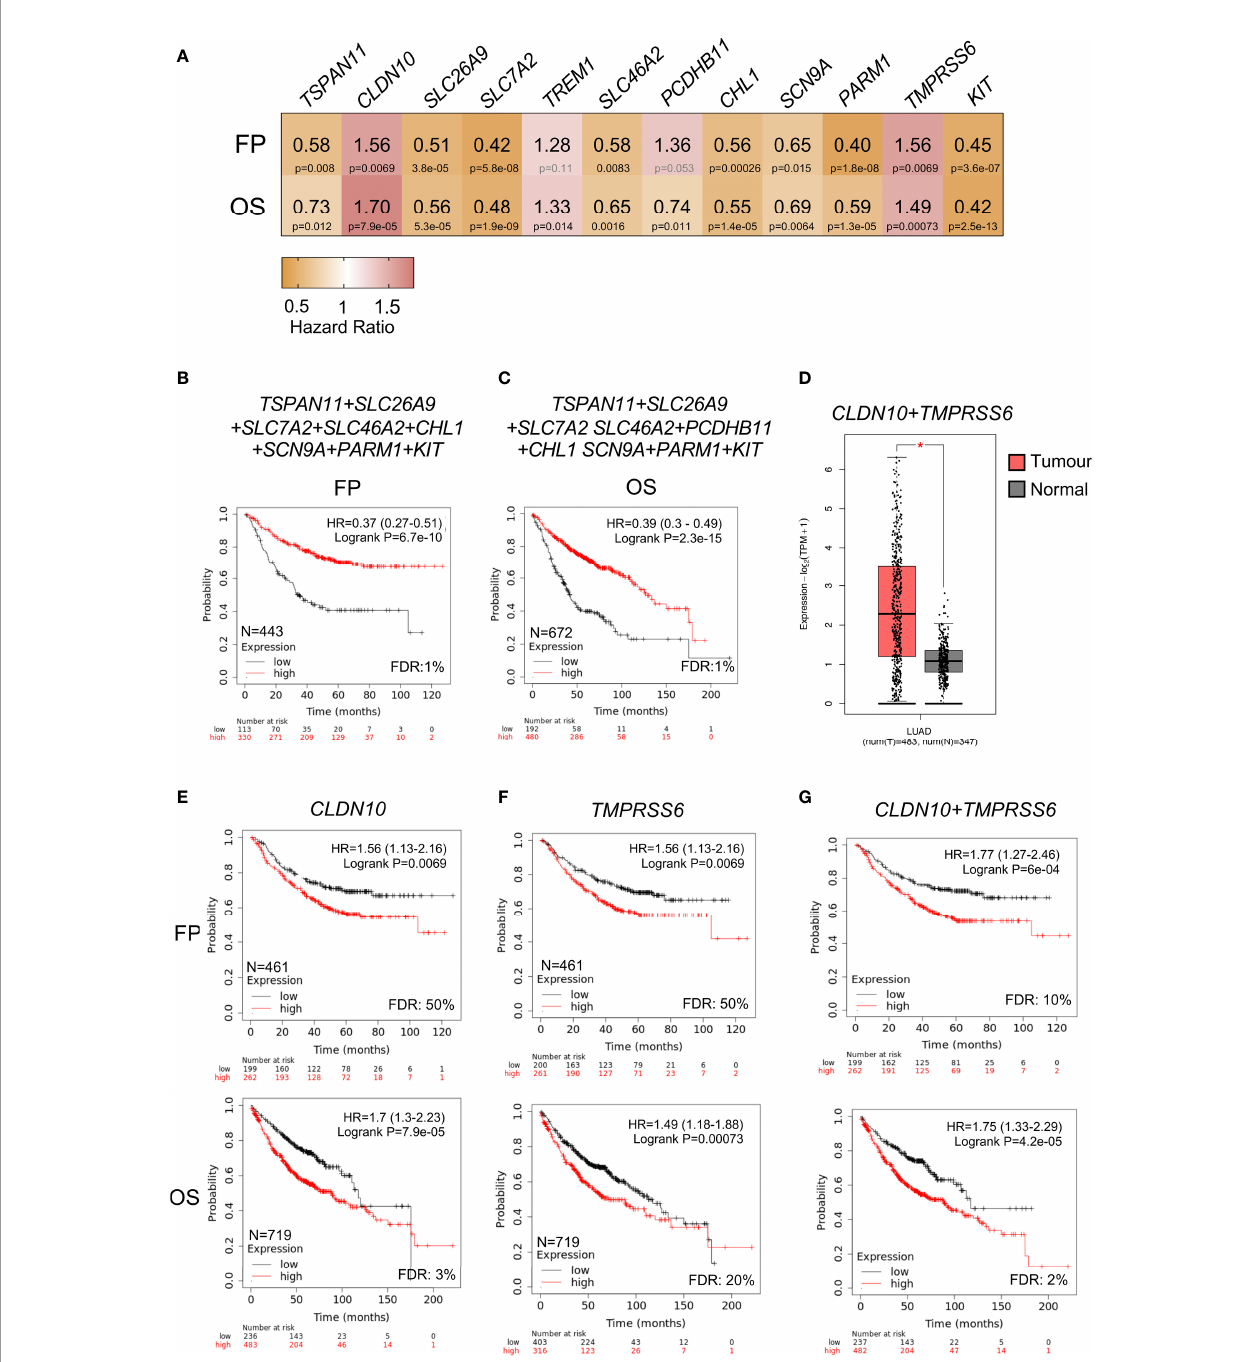
FIGURE 5 | Correlation between expression of upregulated surfaceome genes and LUAD survival. (A) Heatmap showing the HR (yellow color indicates good outcome while red predicts poor prognosis) and p-values (black for signi fi cant and grey for no signi fi cant) of twelve selected genes. (B) Kaplan-Meier survival plots showing the association between combined expression of surfaceome signature with good prognosis for FP ( TSPAN11, SLC26A9, SLC7A2, SLC46A2, CHL1, SCN9A, PARM1 , and KIT) and in (C) for OS ( TSPAN11, SLC26A9, SLC7A2, SLC46A2, PCDHB11, CHL1, SCN9A, PARM1 , and KIT ). (D) Combined expression of CLDN10 and TMPRSS6 genes in samples from LUAD (pink) or normal tissue (grey). Kaplan-Meier survival plots showing the association between the single ( CLDN10 in E ; and TMPRSS6 in F ) or combined gene expression levels ( CLDN10 and TMPRSS6 in G ) with FP (above) and OS (below) for